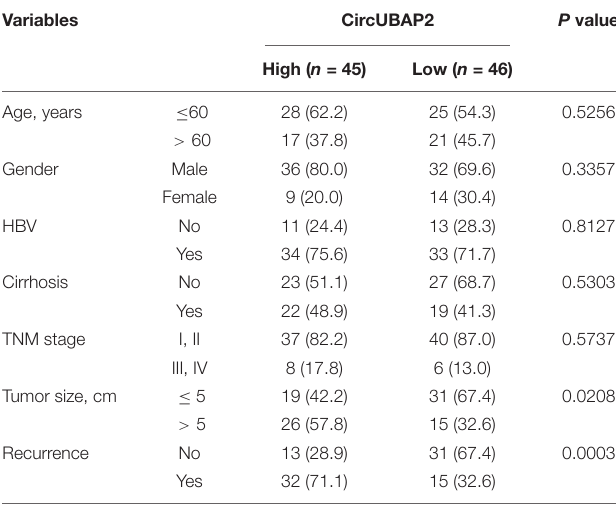
TABLE 1 | Clinicopathological analyses of the differentially expressed circUBAP2 of 91 primary hepatocellular carcinoma patients. Variables